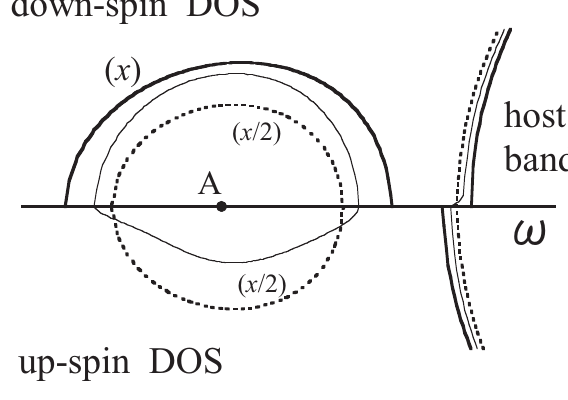
Figure 11. The DOS of the impurity band in the case of IS= ∆ = − 1 : 0 and E = 0 . The thick, thin, and dotted lines represent the cases of ⟨ S M 0 : 5 , and 0 : 0 , respectively. Dot A indicates the impurity level for x → 0 . From Takahashi and Kubo